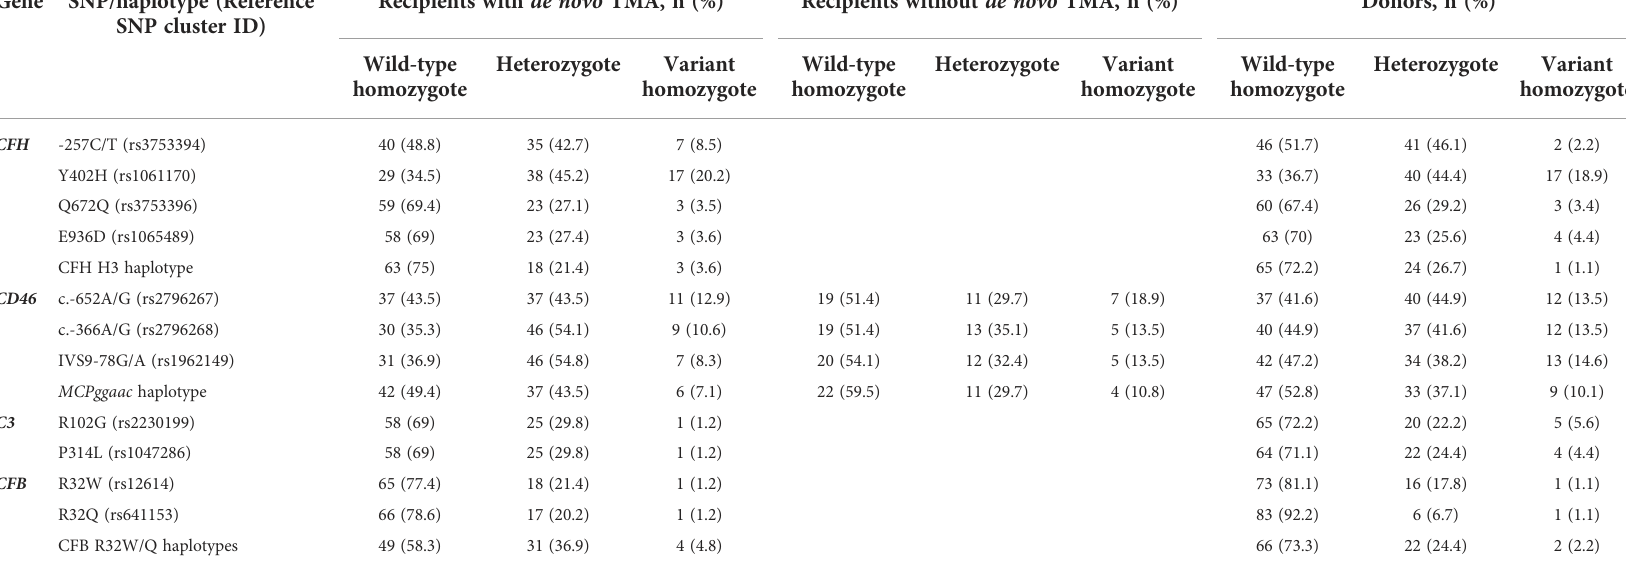
SNP, single nucleotide polymorphism; CFH, complement factor H; CD46, cluster of differentiation 46; C3, complement factor 3; CFB, complement factor B; WT HM, wild-type homozygote; HT, heterozygote; variant HM, variant homozygote; TMA, thrombotic